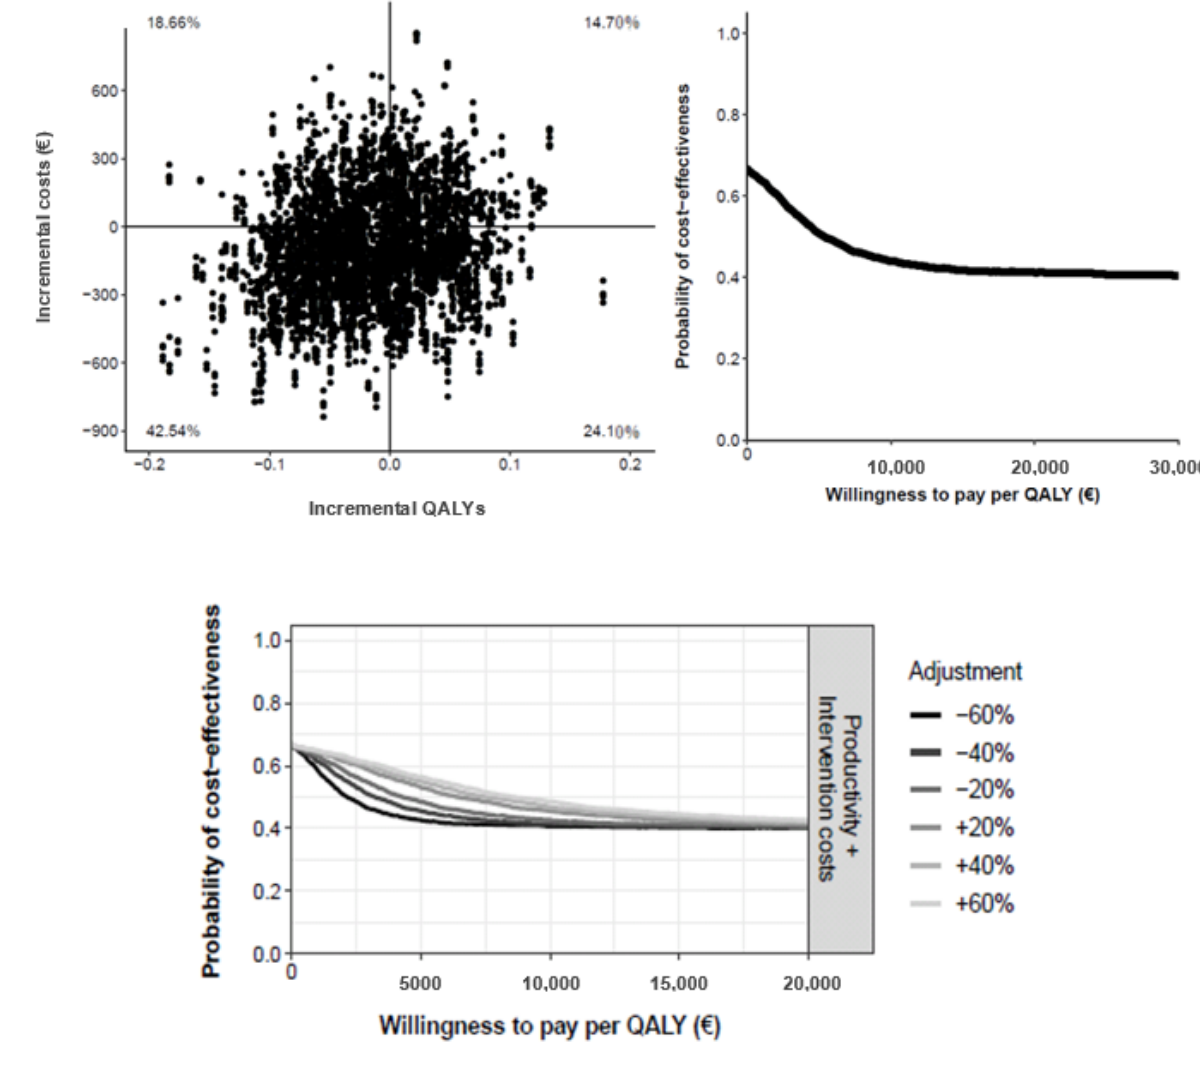
Figure 8. Cost-effectiveness plane (top left) and cost-effectiveness acceptability curve (top right) comparing the effect on quality-adjusted life-years (QALYs) of telephone care versus standard care. Bottom: impact of different cost values on the cost-utility acceptability